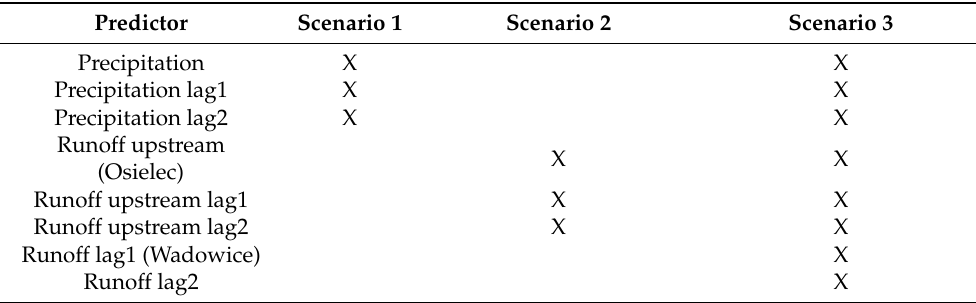
Table 1. The predictor variables used in subsequent scenarios (indicated by X). Lag1 and lag2 are observations from n antecedent